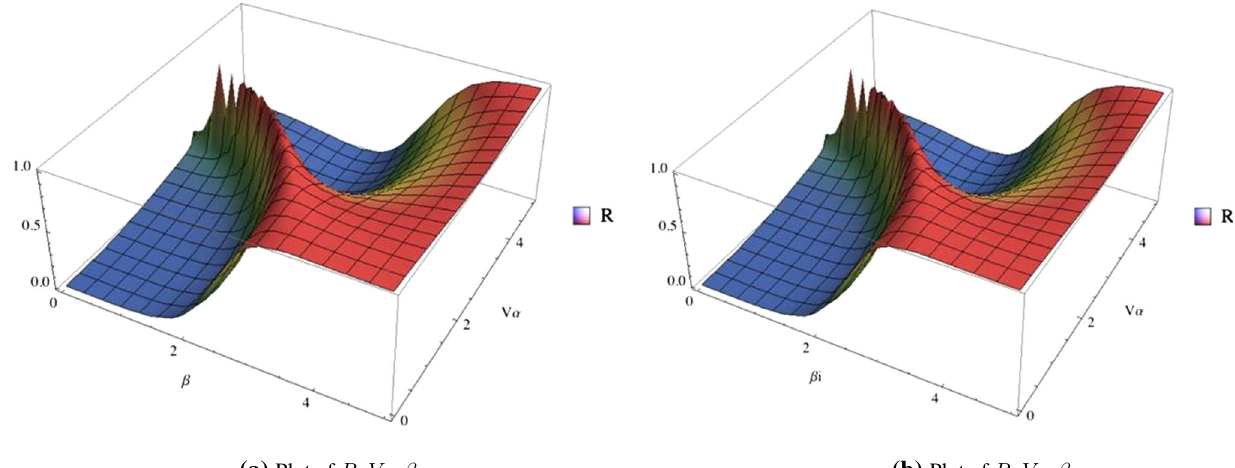
( a ) Plot of R , V α , β . (b) Plot of R , V α , β i . Fig. 4 Reflection of the transition coefficients versus the potential parts